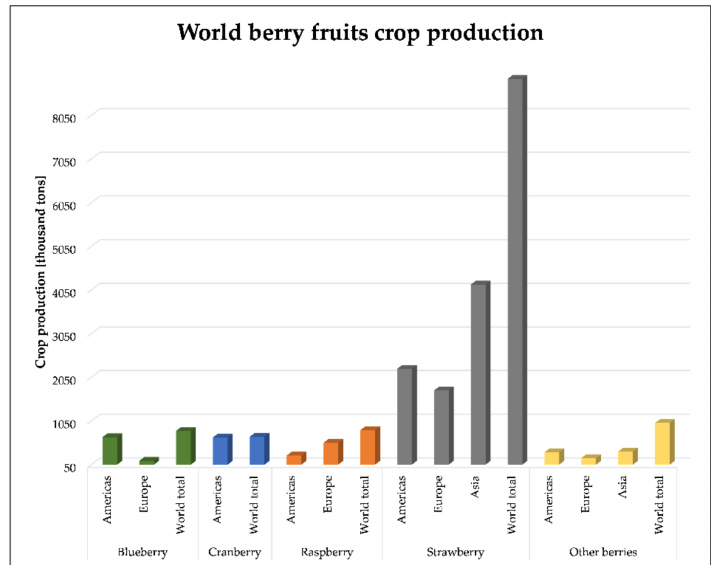
Figure 1. World berry fruits crop production